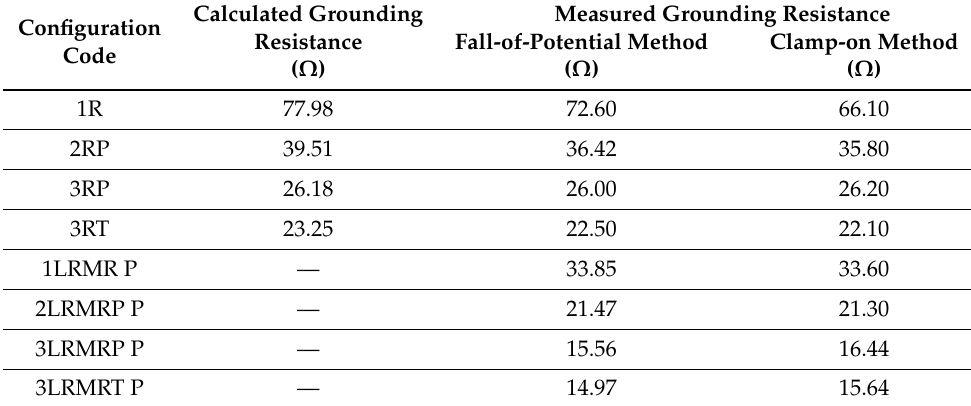
Table 5 outlines the calculated and measured GR values of the GSs implemented in soil 3 (S3), for which the resistivity was 153 Ω ·m. The premixed LRM (P) was used in this soil. Table 5. GR calculations and measurements in S3.